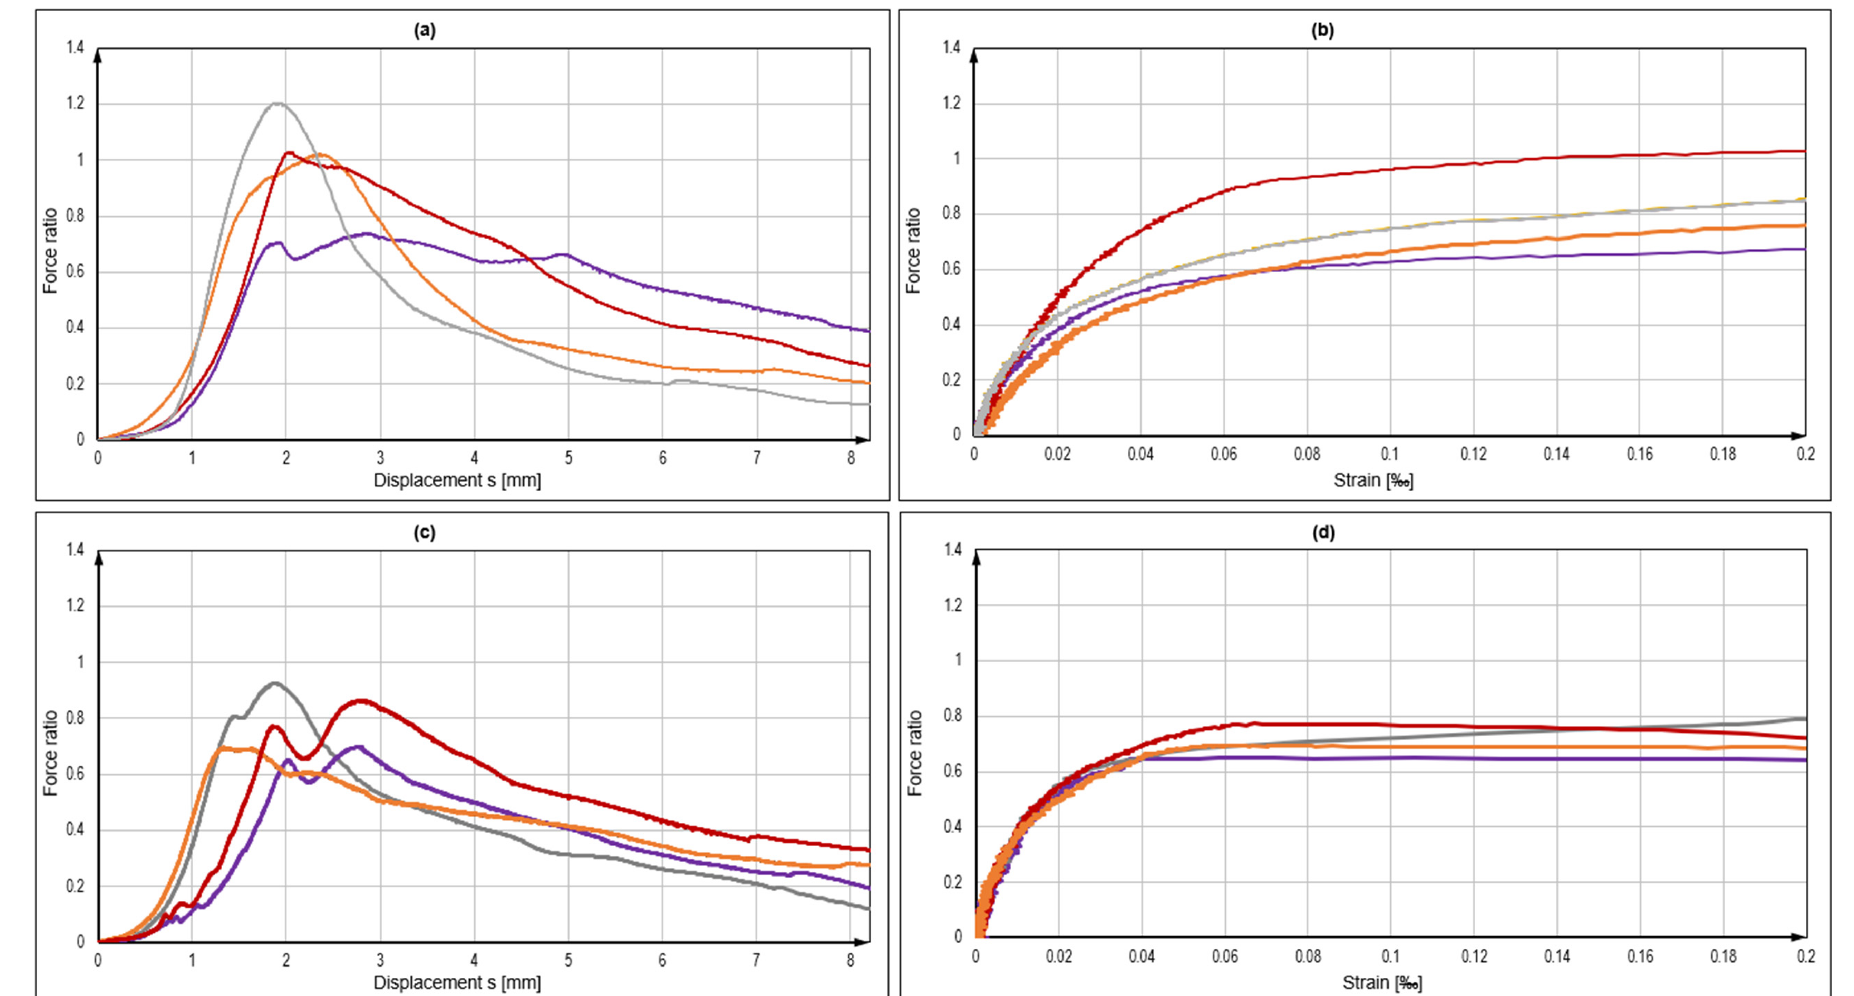
Figure 12. Load displacement curves of confined tests in SFRC ( a ) with corresponding strains ( b ) and of confined tests in plain concrete ( c ) with corresponding strains ( d ). Colours in the left graphs correspond to the ones in the right graphs, but they are otherwise randomly selected signify different samples in the same test series.